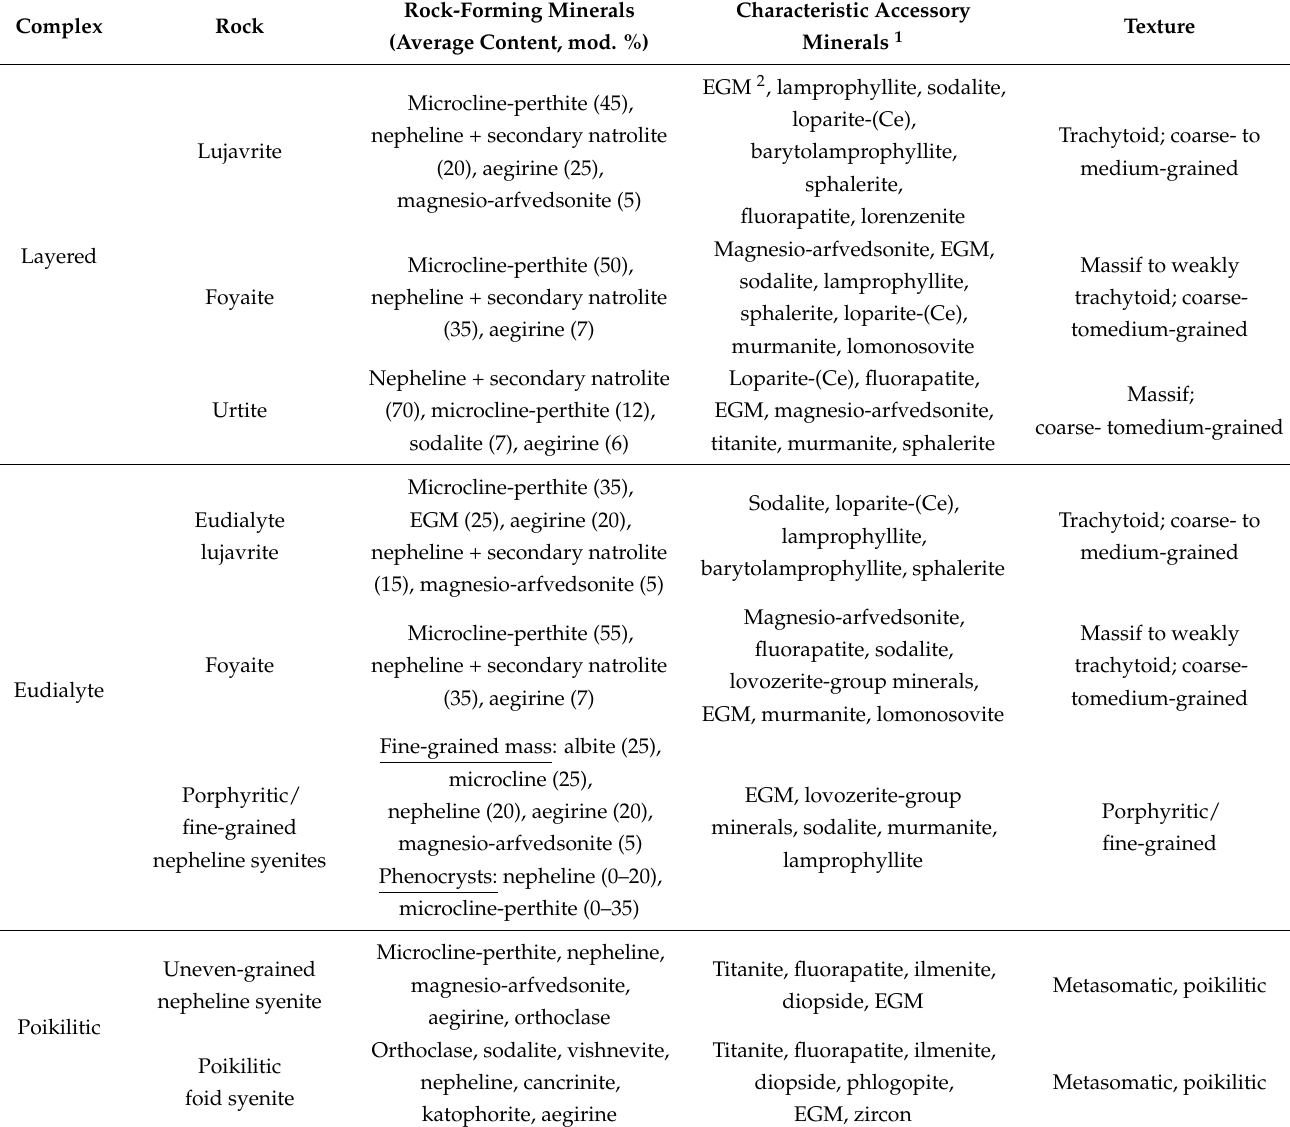
Table 1. Summary of the petrography of the plutonic rocks of the Lovozero